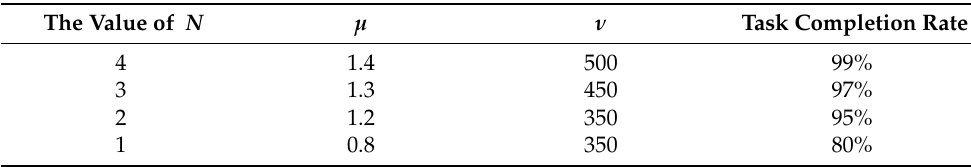
Table 3. Parameters and task completion rate for different N .